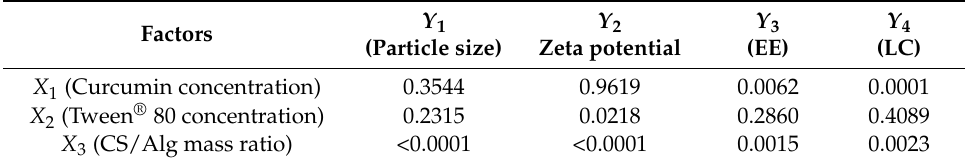
Figure 1. Representative response surface plots showing the effect of the formulation factors (curcumin concentration, Tween ® 80 concentration, and CS/Alg mass ratio) on the ( A ) particle size, ( B ) zeta potential, ( C ) encapsulation efficiency (%), and ( D ) loading capacity (%). Table 3. Significance ( p < 0.05) of the factors in the generated models.